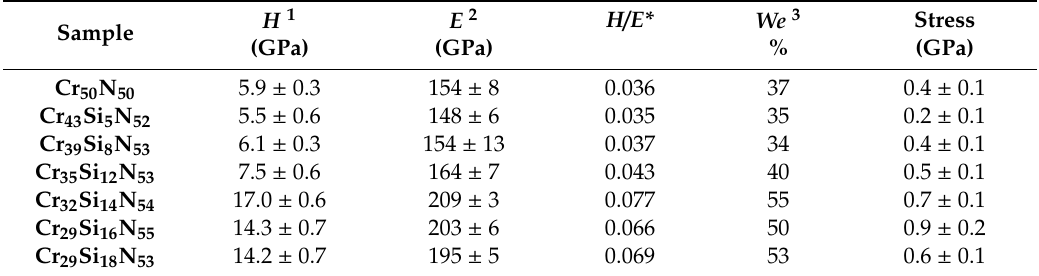
1 H : Hardness. 2 E : Young’s modulus. 3 We : Elastic